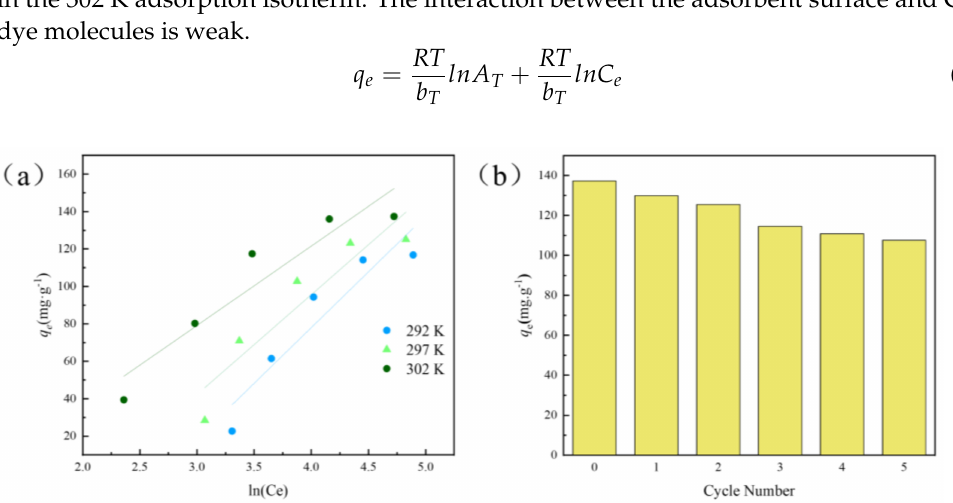
Figure 8. ( a ) Temkin isothermal model of GO − ATP@CS − PVA; ( b ) GO − ATP@CS − PVA adsorption regeneration experiments with CV